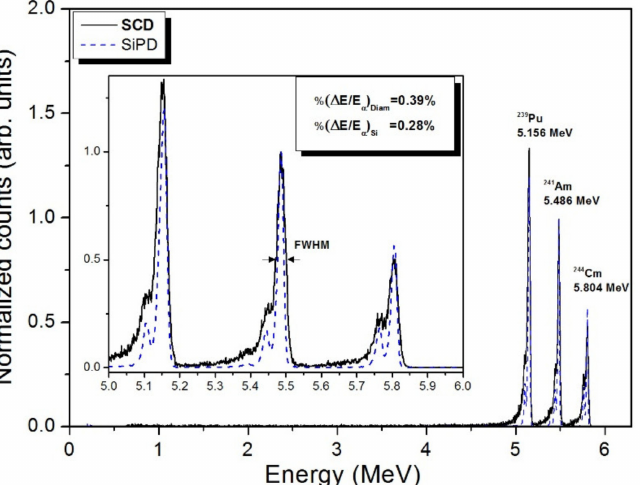
Figure 1. Three alphas’ peak ( 239 Pu- 241 Am- 244 Cm) pulse height spectrum (PHS) recorded using an SCD diamond detector and silicon detector. The energy resolution of the SCD at full width half maximum (FWHM) is about 0.4% as evidenced by the detection of the satellite peaks due to minor emission lines (see the